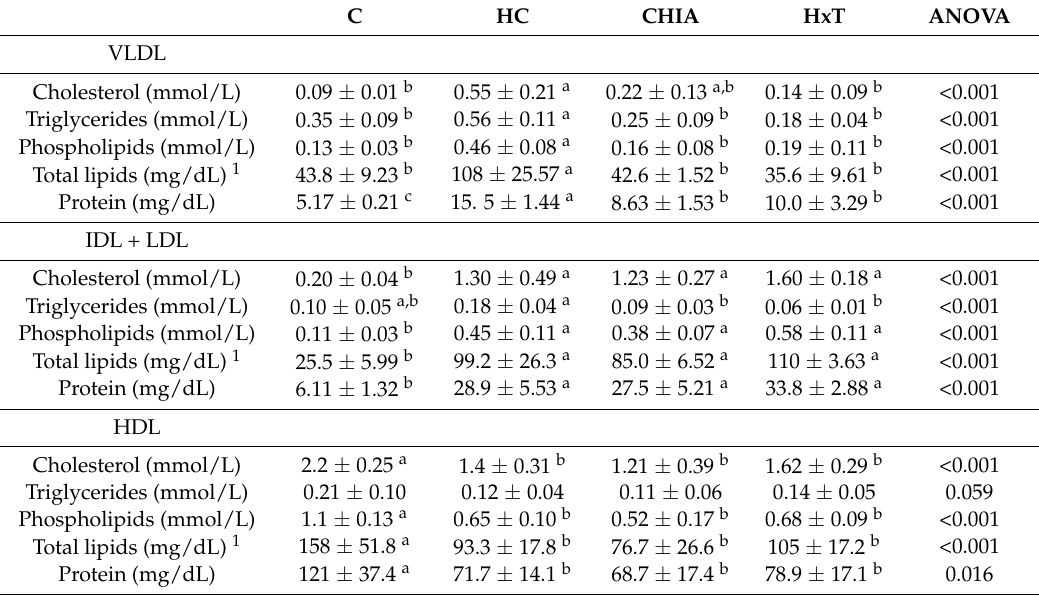
Table 4. Plasma lipoprotein